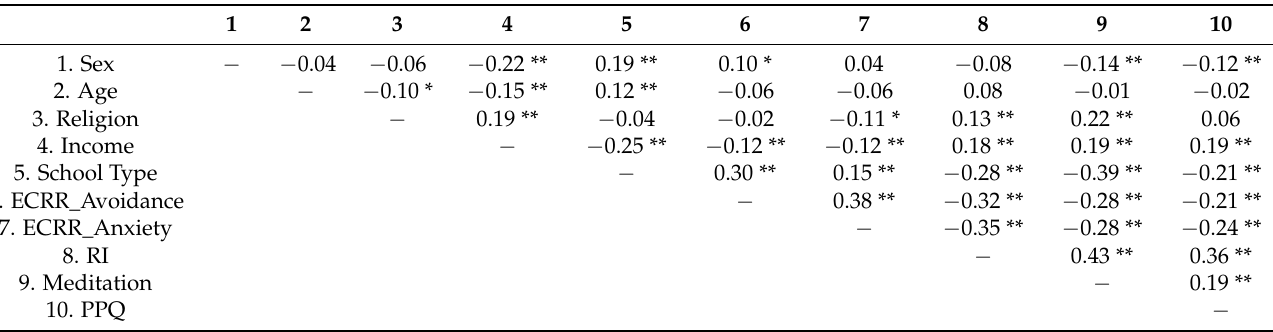
Table 3. Correlation between variables ( n =